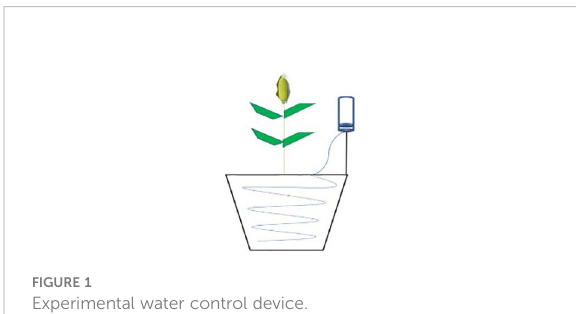
FIGURE 1 Experimental water control